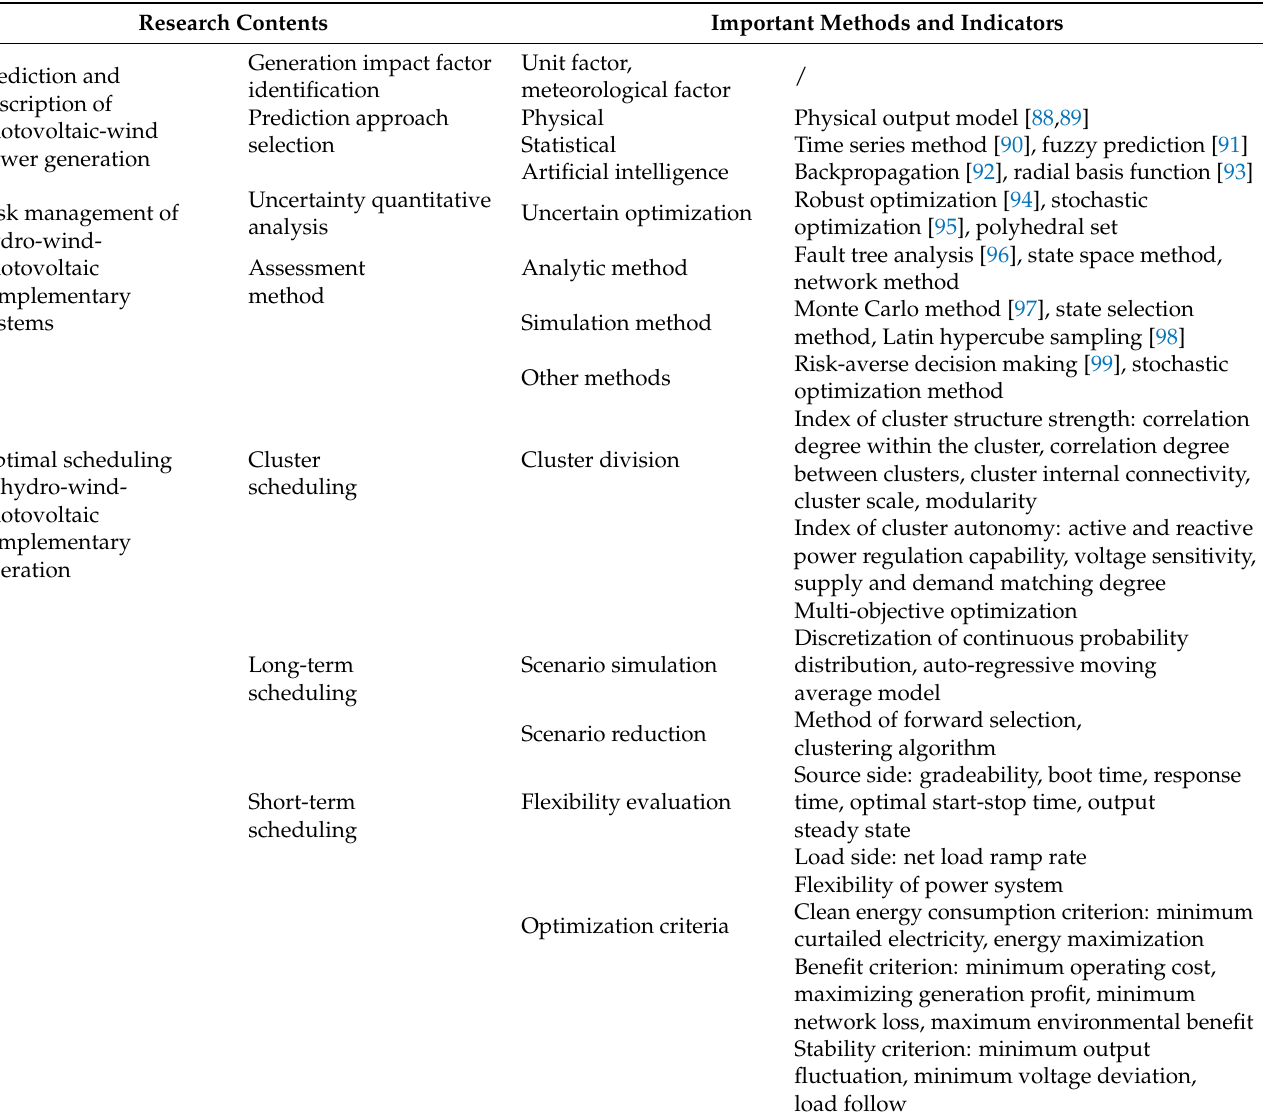
Table 2. Research status of optimal scheduling for hydro-wind-solar renewable energy complemen- tary